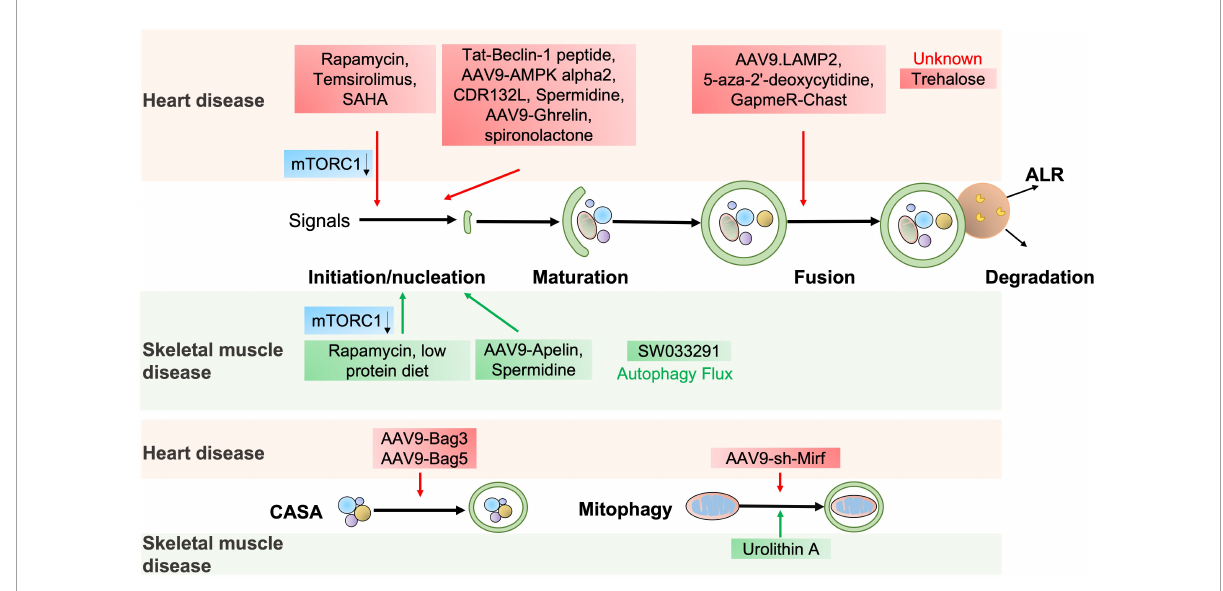
FIGURE4 The potential autophagic targets for striated muscle disease treatment. The diagram includes current drug candidates (small molecules, peptides, ASO, and gene therapy) that act at different stages of the autophagy and might be beneficial in heart or skeletal muscle diseases.